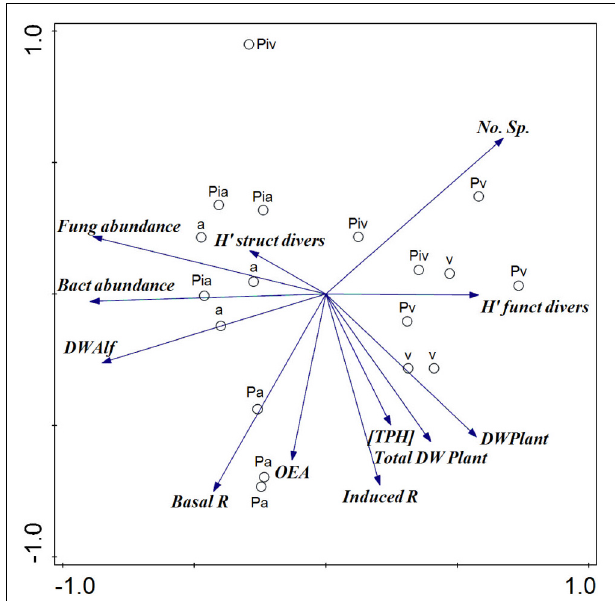
FIGURE 9 | Principal components analysis of plant and soil microbial parameters. PC1 and PC2 accounted for 33.2 and 23.7% of the explained variance, respectively. [TPH], concentration of total petroleum hydrocarbons; No. Sp, number of species; DW Alf, dry weight of alfalfa; DW Plant, biomass in dry weight of spontaneous vegetation; Total DW Plant, biomass in dry weight of alfalfa and spontaneous vegetation; Induced R, substrate-induced respiration; Bact abundance, bacterial abundance by qPCR; Fung abundance, fungal abundance by qPCR; Basal R, basal respiration; OEA, Overall Enzyme Activity; H (cid:48) funct divers, Shannon’s bacterial functional diversity; H (cid:48) struct divers, Shannon’s microbial structural diversity. Treatments: a, planting of alfalfa; Pa, intercropping of non-mycorrhizal poplars with alfalfa; Pia, intercropping of mycorrhizal poplars with alfalfa; Pv, planting of non-mycorrhizal poplars with spontaneous vegetation; Piv, planting of mycorrhizal poplars with spontaneous vegetation; v, spontaneous vegetation (unplanted